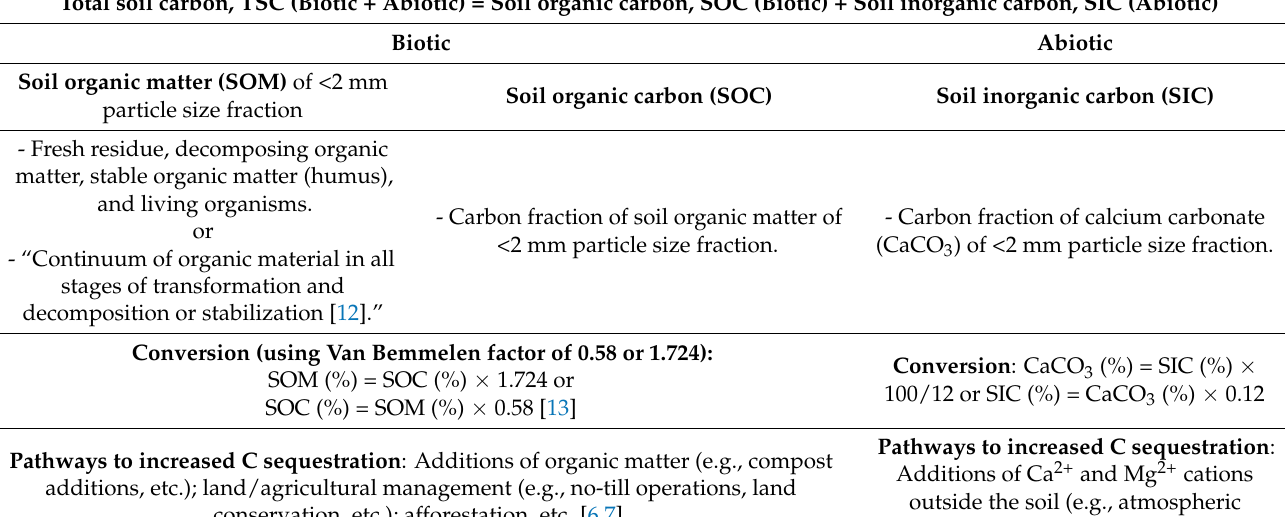
Table 1. Total soil carbon: soil organic matter (SOM), soil organic carbon (SOC), soil inorganic carbon (SIC), and carbon sequestration pathway (adapted from Mikhailova et al., 2019